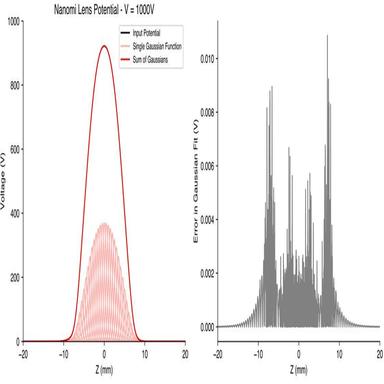
Left Panel: Axial potential and Gaussian fitting method. The red line displays the sum of Gaussian function fit to the axial potential data (black, not visible), and the light red line displays each Gaussian used to obtain the fit. Right Panel: Absolute error in the fit between the axial potential obtained from the FEM method, and the sum of Gaussian fit.